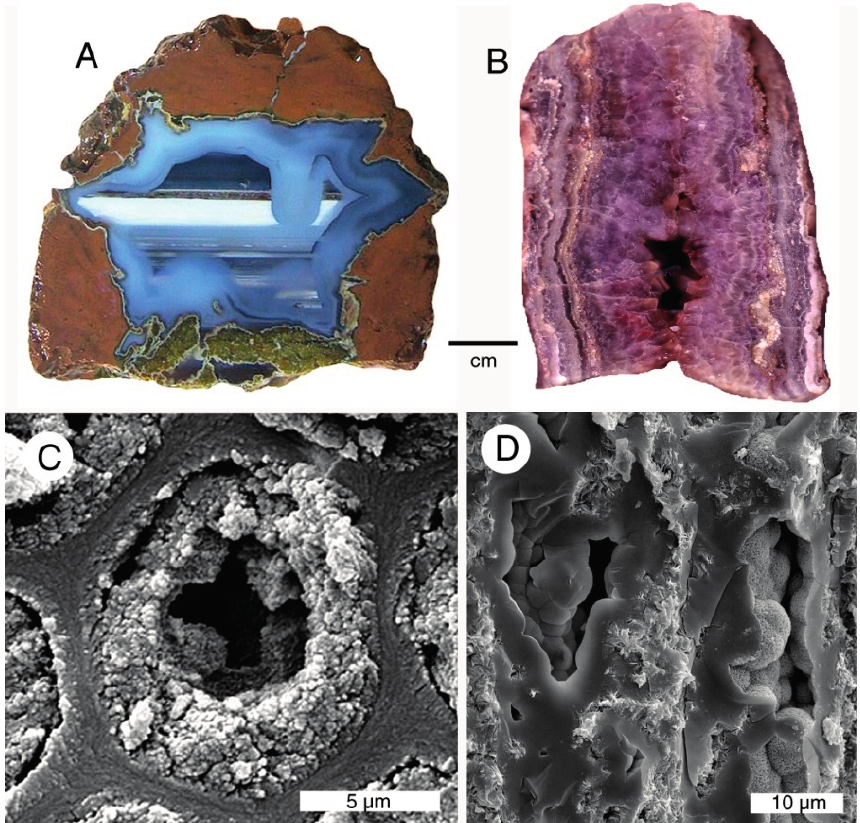
Figure 19. ( A ) This “thunderegg” nodule from central Oregon, USA originated when a vesicle in welded tuff became filled with silica minerals that precipitated after groundwater entered the cavity via fractures in the host rock. The star shape shows the entry points for the silica-bearing fluid. The first stage of mineralization was deposition of light blue gray chalcedony around the periphery of the cavity, including a stalactitic shape at upper right. Later silica precipitation produced successive horizontal layers of dark translucent chalcedony, with a prominent white layer of common opal; ( B ) Vein from Arizona, USA shows layers of crystalline quartz (amethyst variety) parallel to the side walls, with well-terminated crystals on interior surfaces of a midline cavity; ( C ) Transverse view of fossil wood from locality 2 (Rainbow Ridge opal mine). Cell walls mineralized with vitreous opal separate each tracheid. The lumina are partially filled with granular opal-CT. The structure resembles geodes, where minerals precipitate on the side walls of a circular chamber; ( D ) Radial view of two tracheids from location 2 (Rainbow Ridge opal mine). Botryoidal layers of opal-CT coat the inside surfaces of cell walls, with the central interior remaining empty. This architecture is reminiscent of veins, where mineralizing fluids enter a linear fracture. The fossil wood thus contains a combination of geode and vein characteristics, originating from multiple stages of mineral precipitation in an elongate open space having a circular